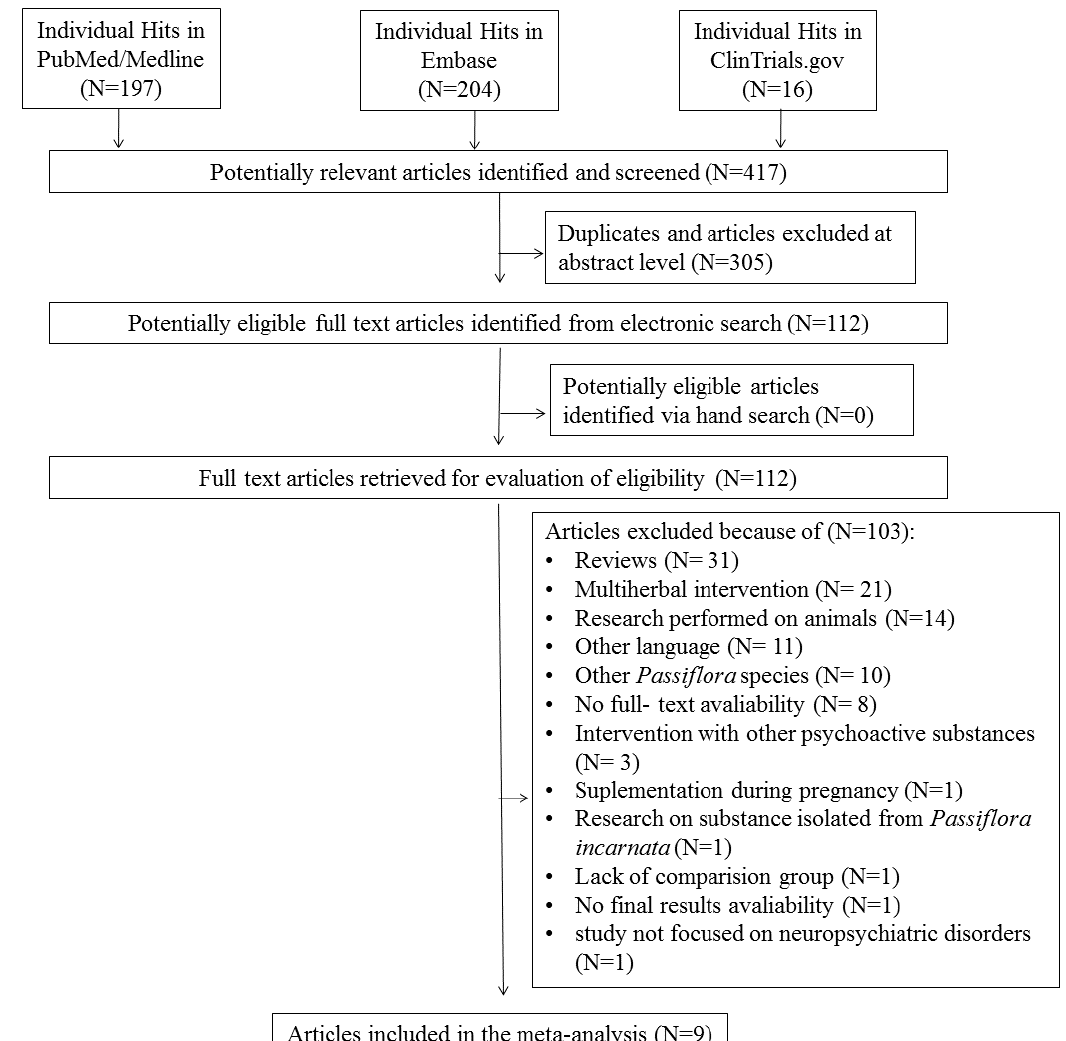
Figure 1. Study Figure 1. Study flowchart.